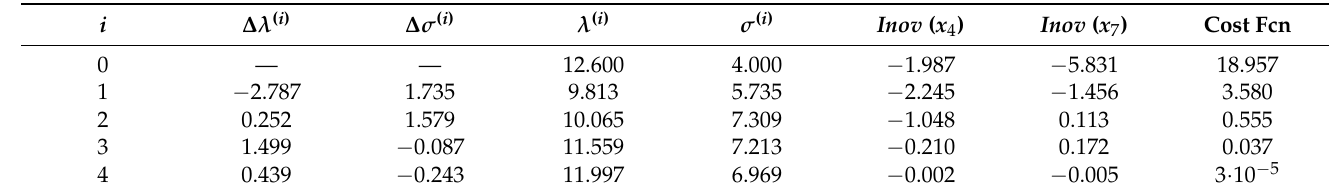
Figure 9. Contour plots of the FSM cost function in the space of control increments ( 𝛿𝜆 along the horizontal axis and 𝛿𝜎 along the vertical axis). The values of 𝛿𝜆 and 𝛿𝜎 at the cost function min- imum are the incremental adjustments to controls at the operating point.